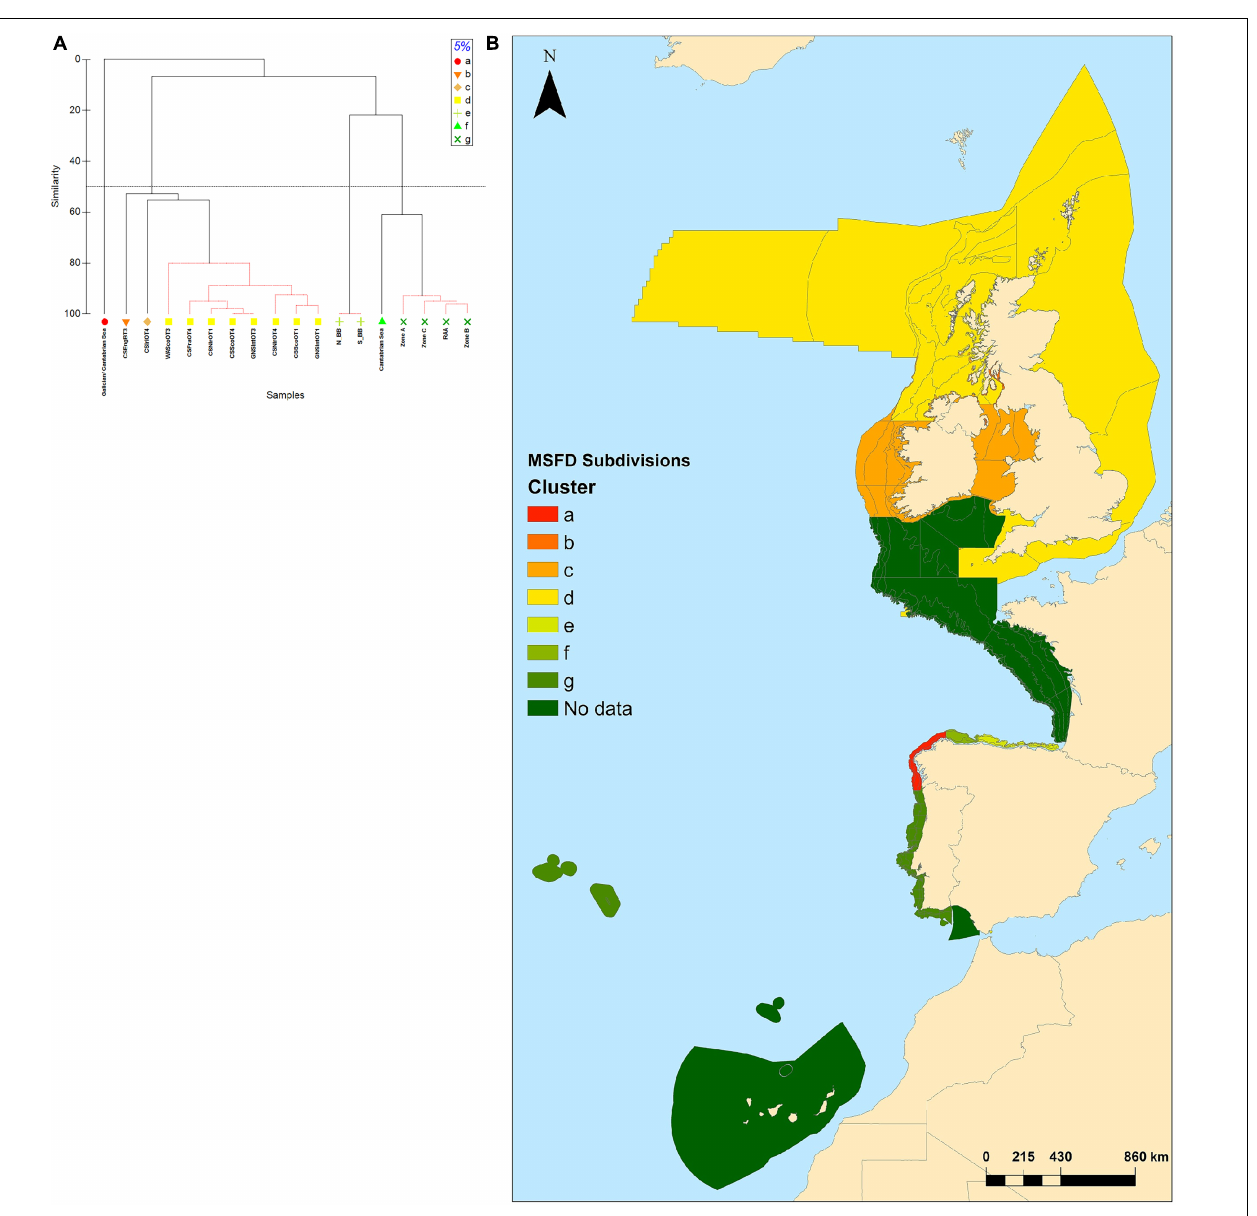
FIGURE 5 | Dendrogram resulting from cluster analysis of Food webs transformed average trend, reported by Member States (A) and spatial distribution of the cluster assemblages (B) . Five assemblages and three outliers were identified at the 57% level of